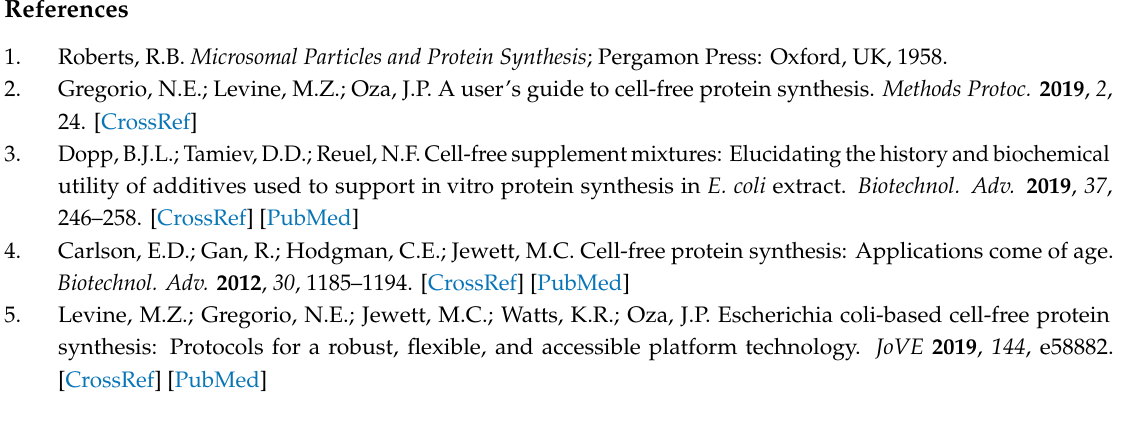
Table S2: The relative protein productivity with all processing volume (250–1000 µ L, combined), Figure S1: The SDS-PAGE of the cell-free reaction mixture after reaction at 37 ◦ C for 24 h, Figure S2: The linear relationship between sonication volume and energy input, Figure S3: The total protein (mg / mL) and relative sfGFP productivity (%) of cell extract variants of di ff erent sonication energy input ranged from 50 J to 2000 variants of different sonication energy input ranged from 50 J to 2000 J.